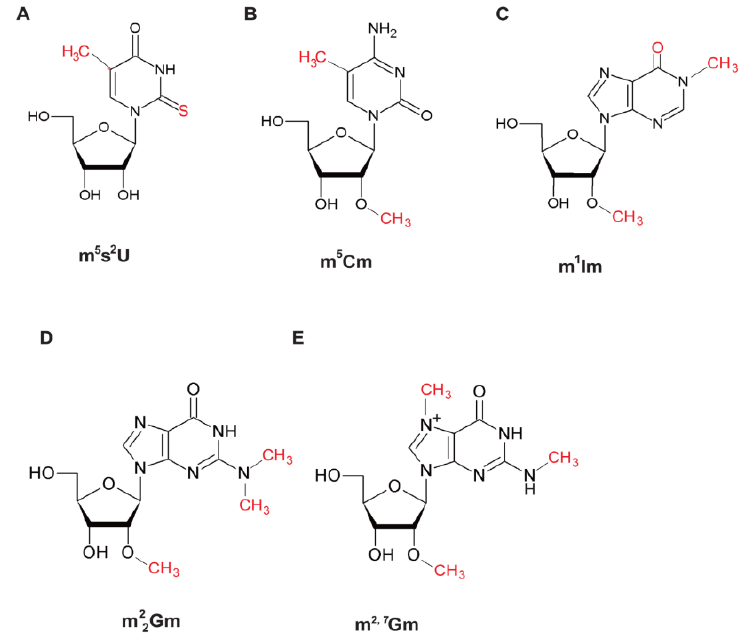
Figure 3. Thermophile-specific modified nucleosides in tRNA. Abbreviations of modified nucleosides are given in Supplementary Table S1. ( A ) m 5 s 2 U. ( B ) m 5 Cm. ( C ) m 1 Im. ( D ) m 22 Gm. ( E ) m 2, 7 Gm. The modifications are indicated in